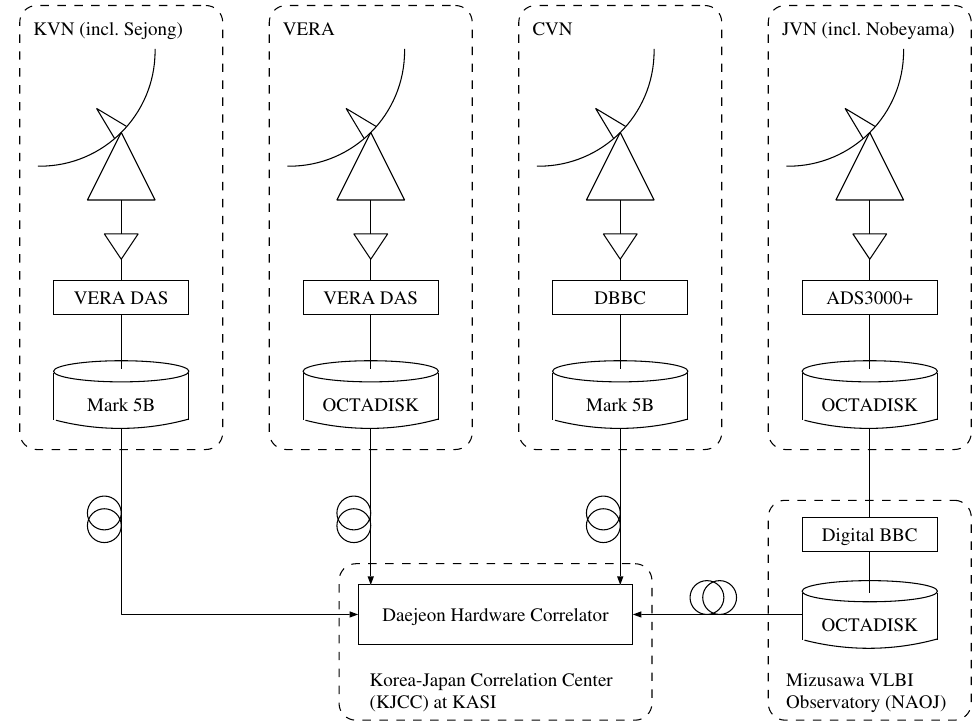
Figure 3. Schematic diagram of data flow of current EAVN observations. ‘DAS’ represents data acquisition